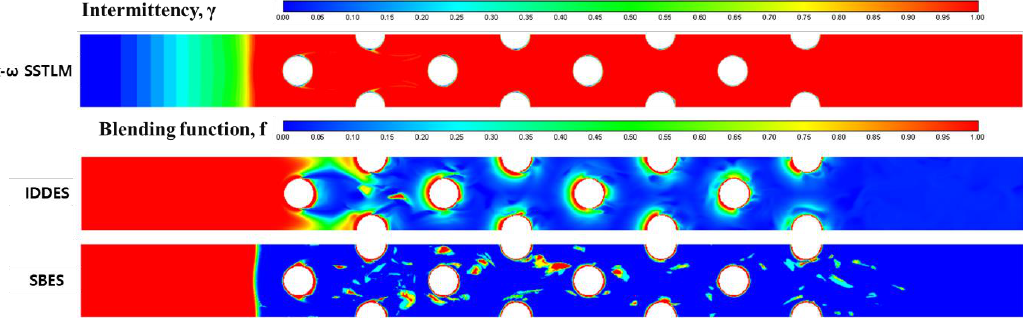
Figure 14. Intermittency and blending function distributions on the xy-plane at the center height of the z-axis.